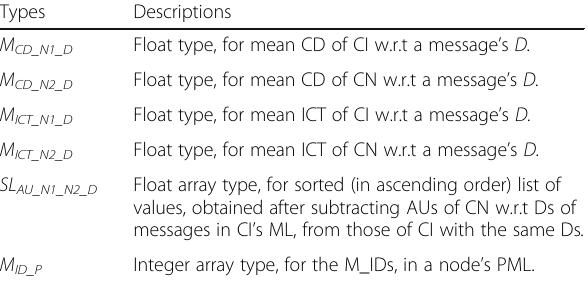
Table 9 Data types used in the model of